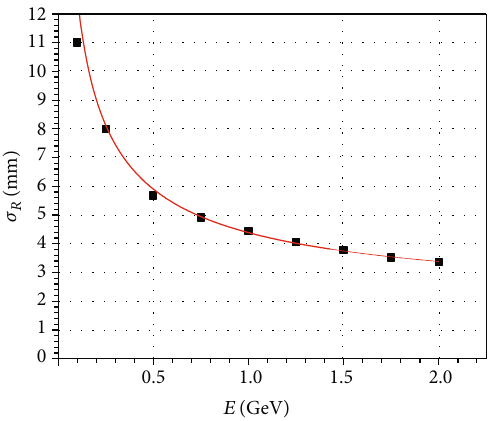
Figure 7: Dependence of the two-dimensional position resolution on electron energy.